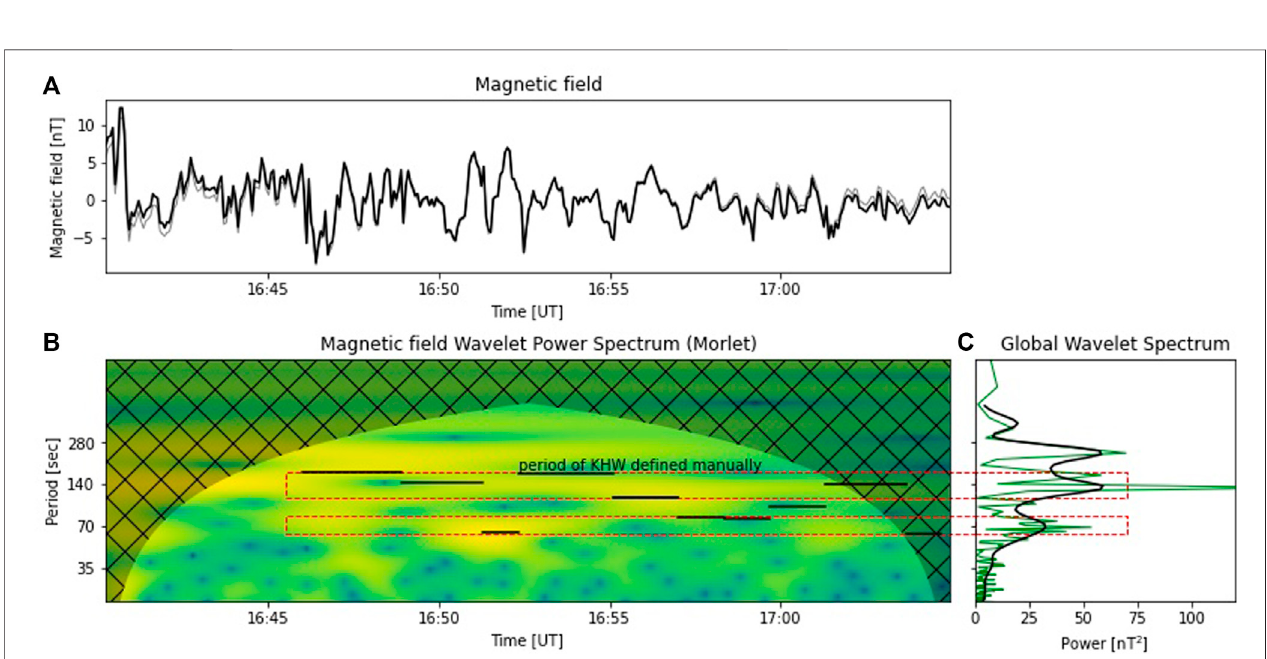
FIGURE7| WavelettransformanalysisofSiscoe-derivedmagnetic fi eldnormalcomponent,nT,fromClusterSC1between16:40and17:05UT: (A) originalseries (black) and inverse (gray) wavelet transform; (B) the normalized wavelet power spectrumand cone ofin fl uence hatched and (C) the global wavelet for periods outside of the cone of in fl uence (COI) (black) and Fourier power spectra (green). Note that the period scale is logarithmic. The horizontal lines in panel (B) indicate periods of KHW de fi ned manually as the time between dashed lines for corresponding time intervals in Figure 3 . The dashed red rectangles correspond to two period bands from 62 to 82 s and from 113 to 173